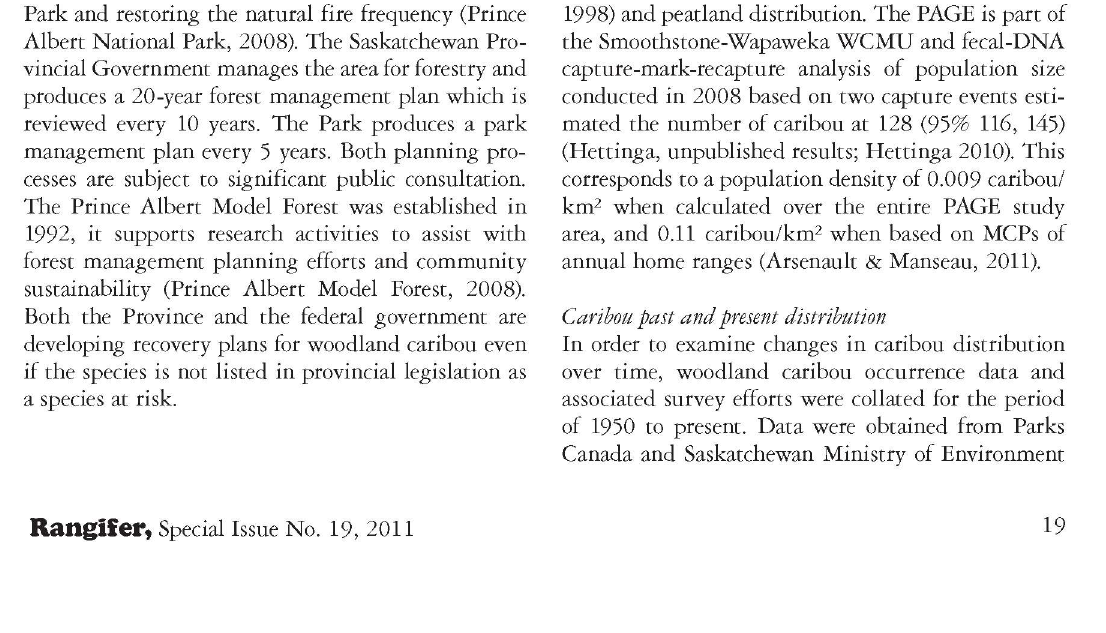
Fig. 1. Prince Albert Greater Ecosystem, Saskatchewan, Canada.